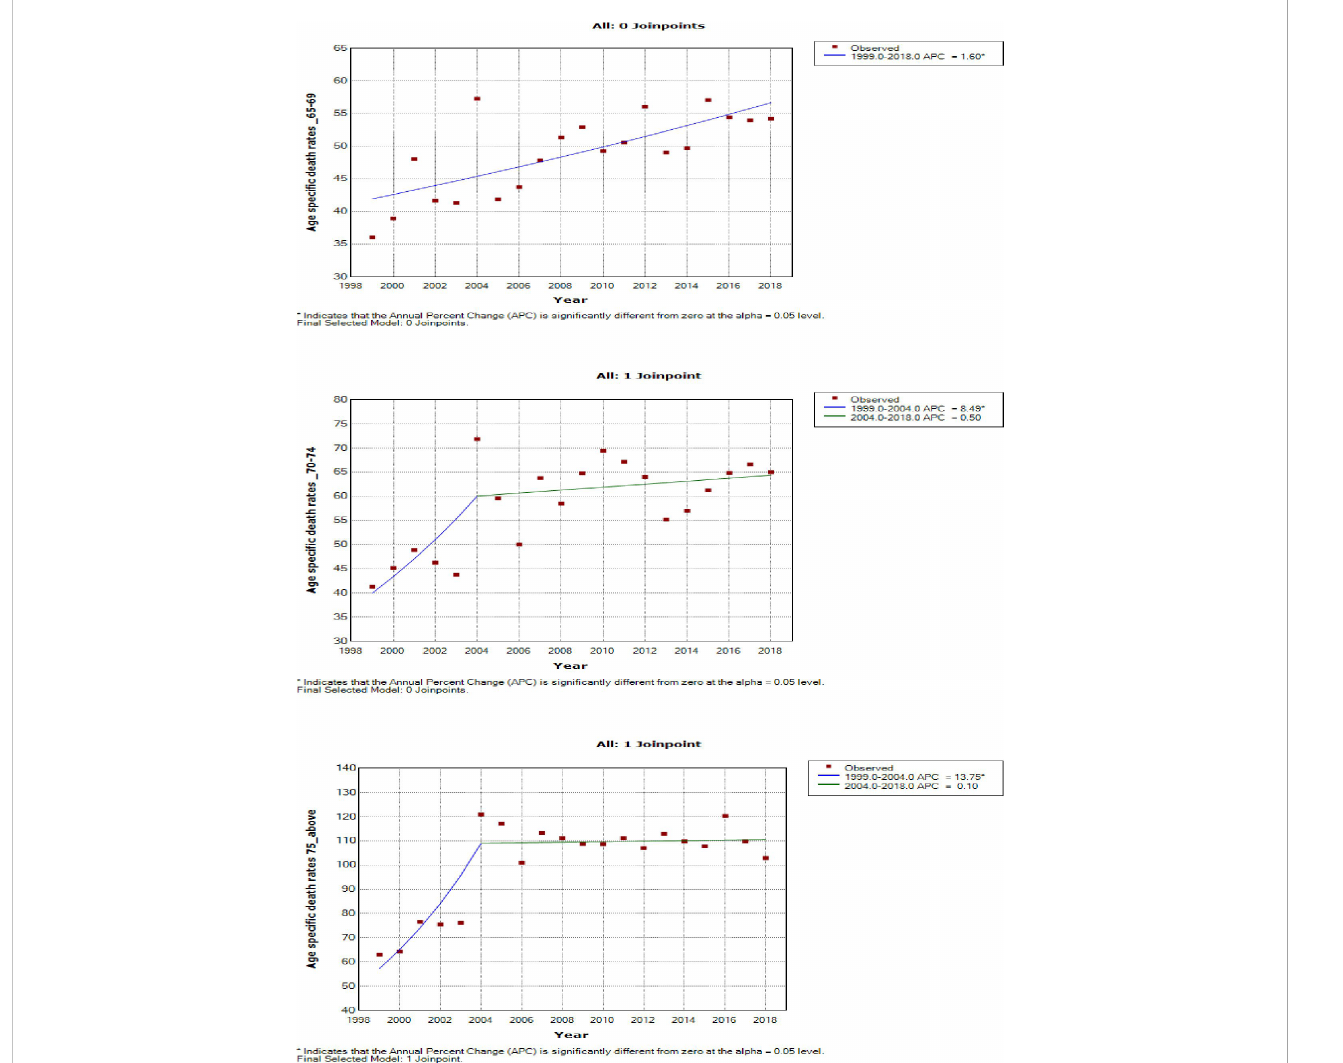
FIGURE 9 Joinpoint trends of age-speci fi c death rates of breast cancer in South Africa, 1999 – 2018, among 65 years and above (5-year